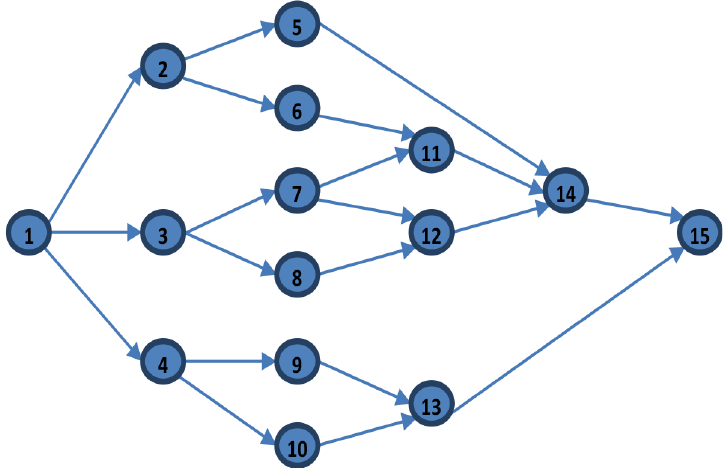
Figure 7. Network Diagram for experiment number